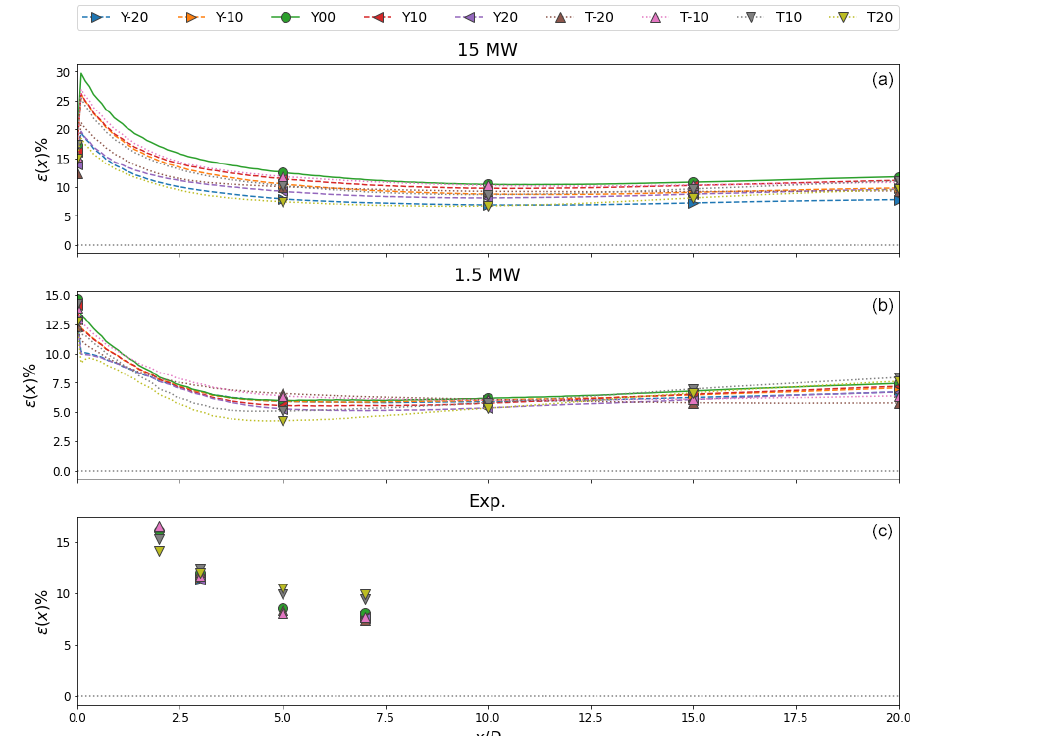
Figure 10. FLORIS streamwise flow field error from the proposed model for 15MW (a) , 1.5MW (b) , and scaled model turbine (c) inputs. Error is greatest in the near wake as FLORIS is not designed to represent near-wake phenomena. Flow field error decreases downstream of the turbine reaching a minimum near x/D = 5. In the far wake, error increases from overpredicting the wake velocity deficit.